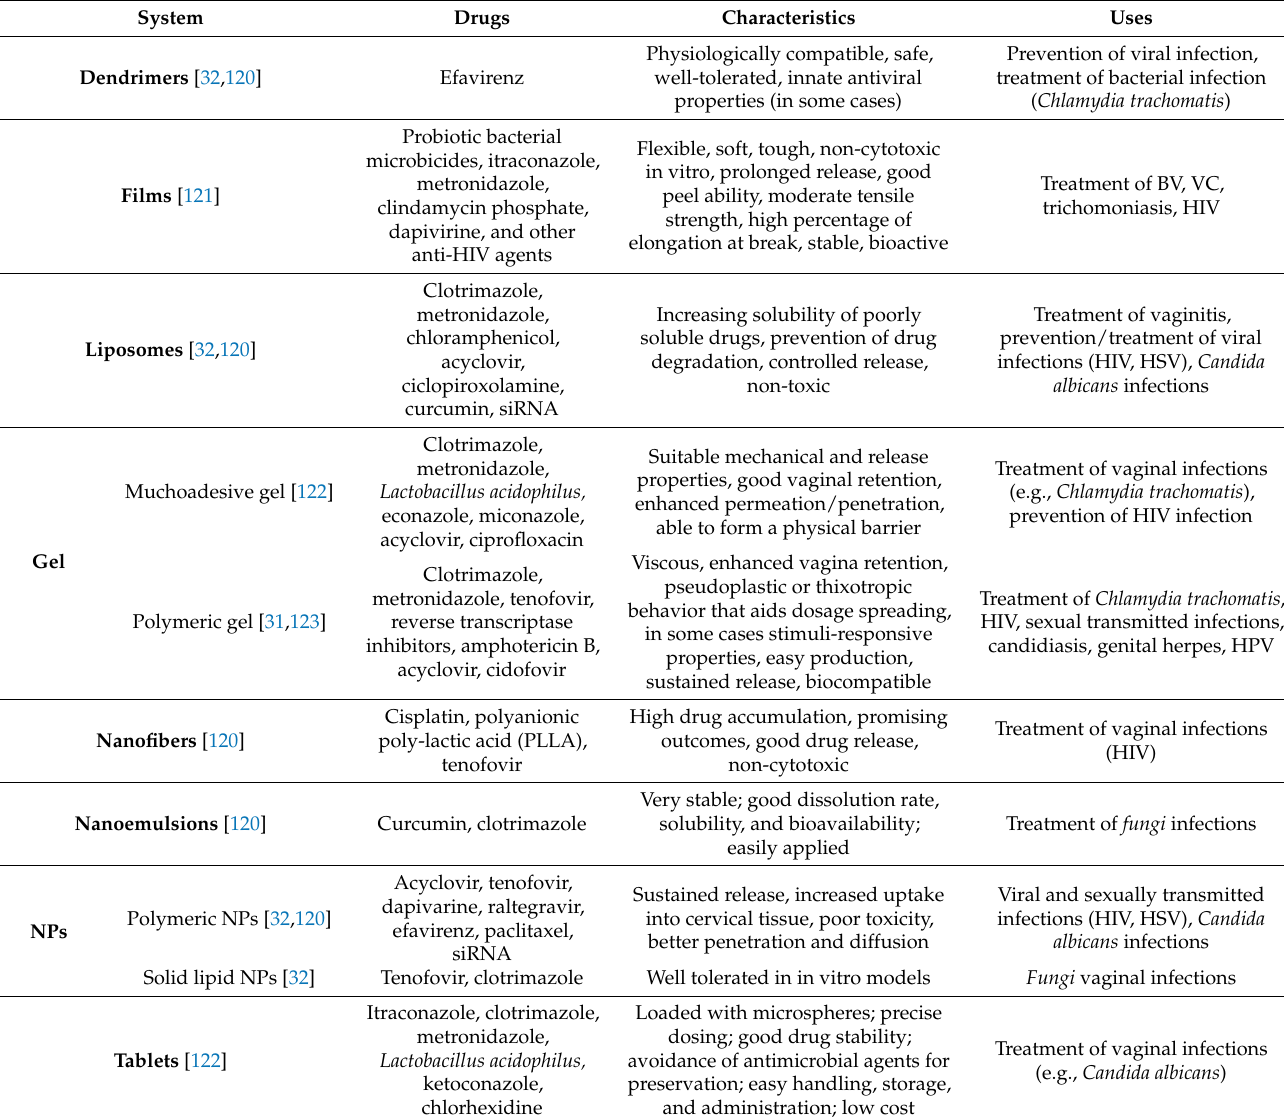
Table 3. Main innovative strategies for the vaginal delivery of antimicrobials